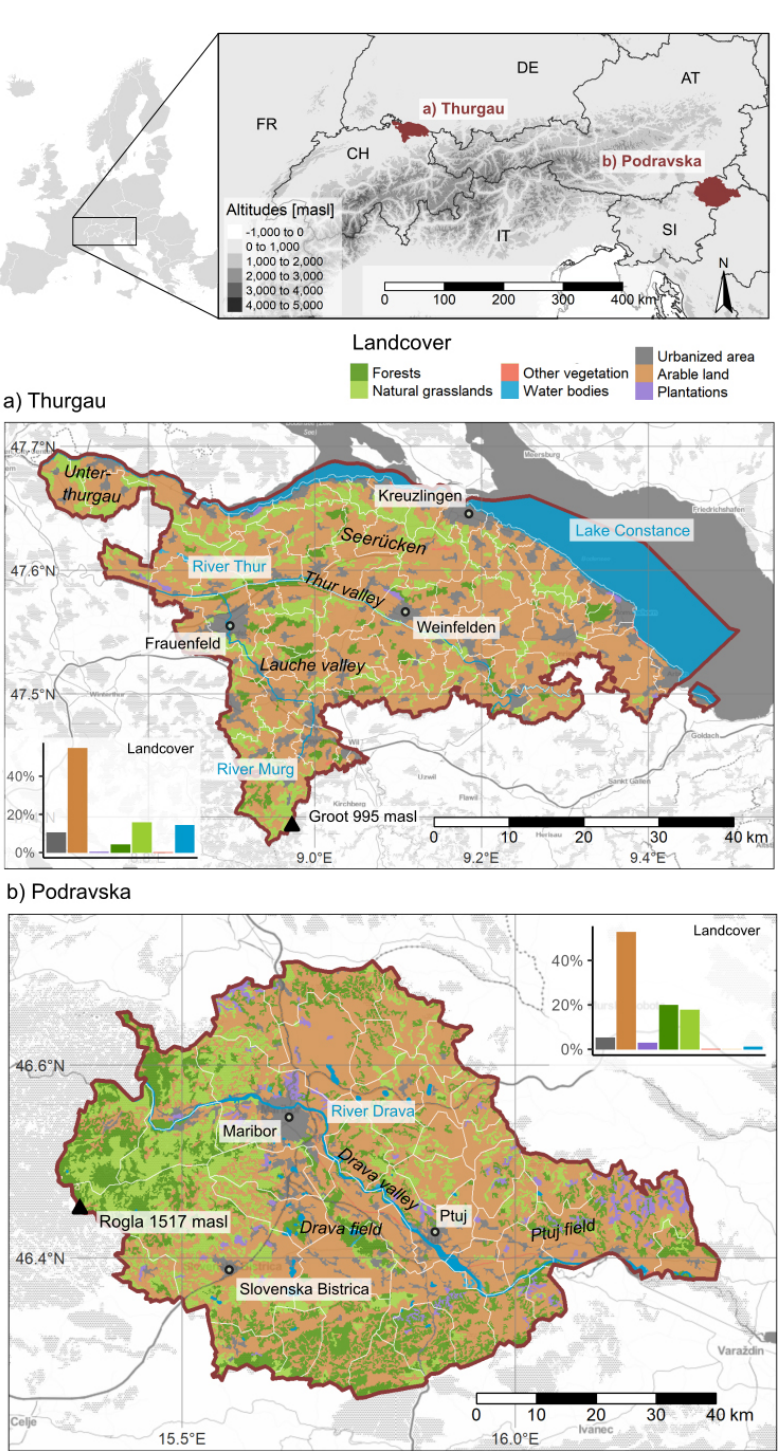
Figure 1. The two study regions (a) Thurgau and (b) Podravska within the European mountain region. The political border of the study regions is marked in red, and the LAU2 regions are marked with white. The black labels present the most important cities and common known subareas (italic). The blue labels present the largest important rivers and lakes. The colours present the regional land cover adapted and modified by the Corine Land Cover (CLC, 2022). The land cover’s share is shown in the